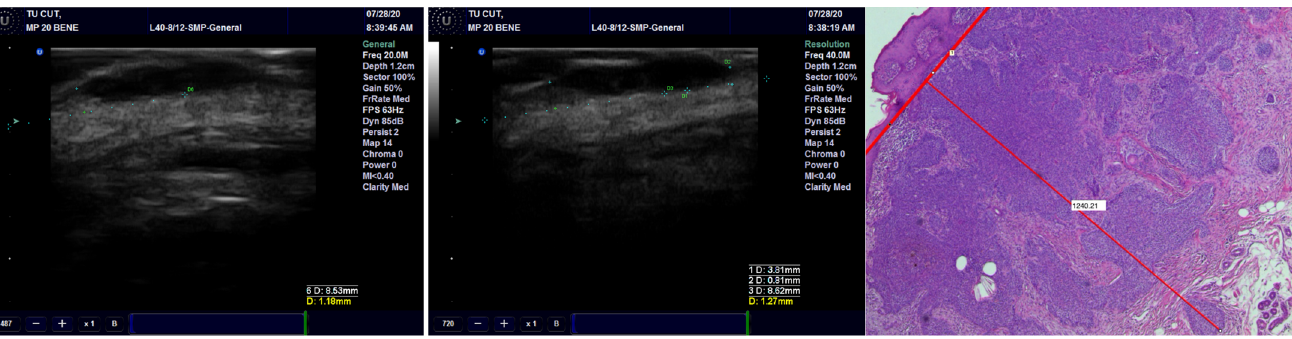
Figure 3. The thickness of the tumor, measured on US with 20 MHz and 40 MHz transducers, compared with the pathological image of the tumor showing very high occurrence of US. Table 2. Tumor thickness measured pre- and post-operatively, with 13, 20 and 40 MHz transducers, as well as the inter-class correlation coefficient between echography and pathological